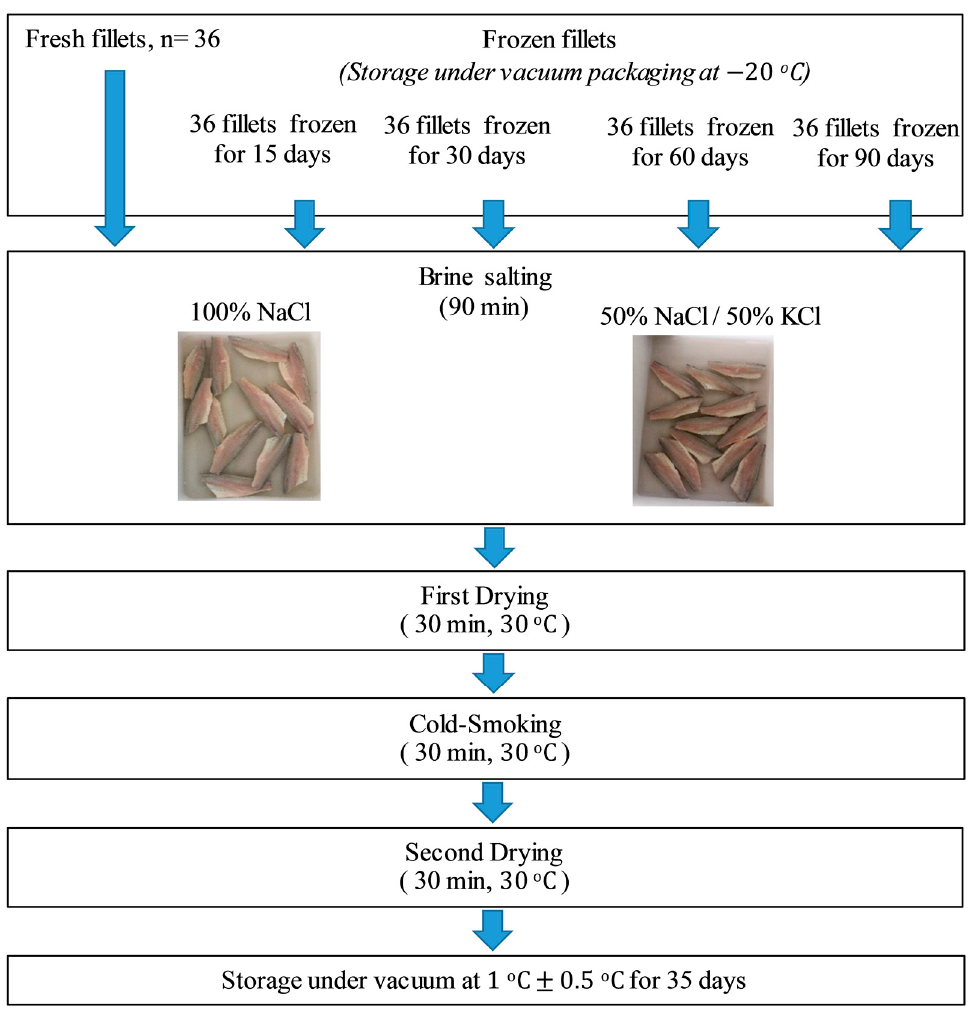
Figure 1. Flowchart of the experimental design.